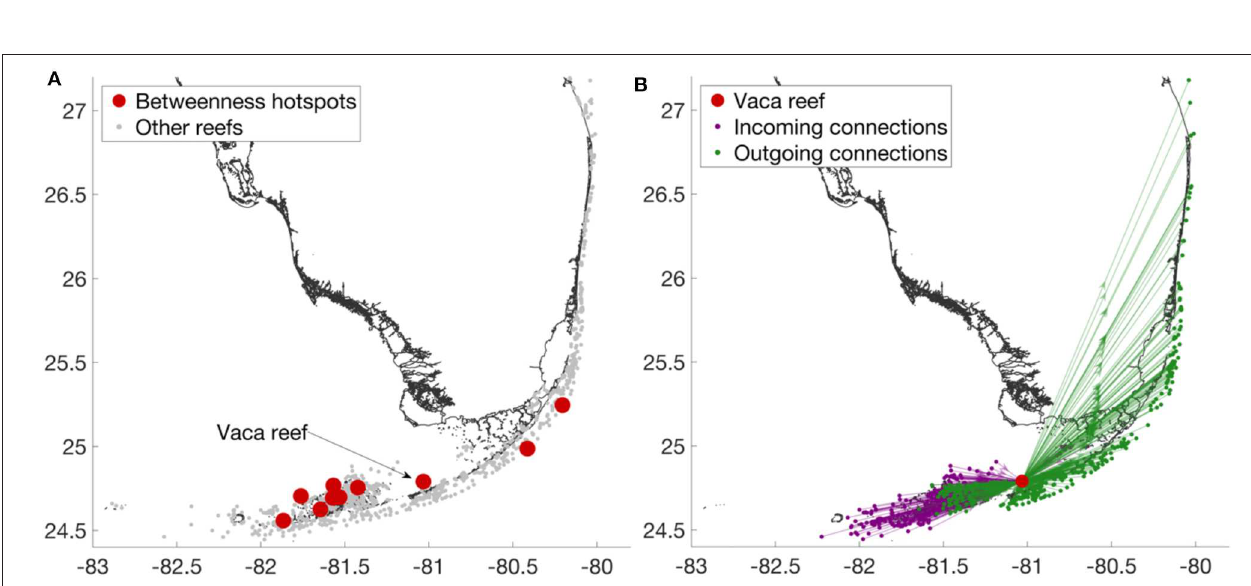
FIGURE 6 | Top 1% reefs most in need of protection and best suited to restoration projects. Reefs that need protection are located on the same areas as the best source reefs. Reefs best suited to restoration are more spread in the FRT as both inner- and outer-shelf reefs can be suitable.